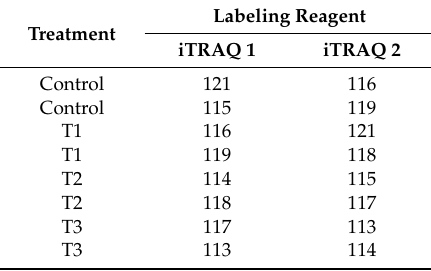
Table 1. iTraq labeling reagents used in each run. T1, T2, and T3 refer to 0.5, 2, and 8 µ g L − 1 , respectively. iTRAQ 1 refers to the first run, and ITRAQ 2 refers to the second